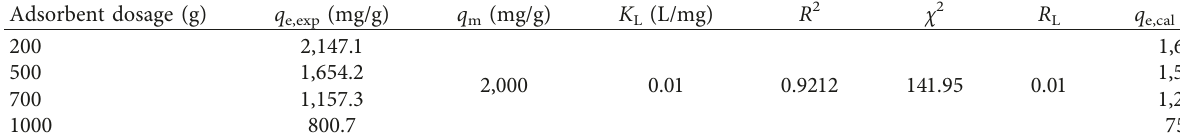
Table 2: Langmuir isotherm constants using modified bagasse using a pilot-scale system.